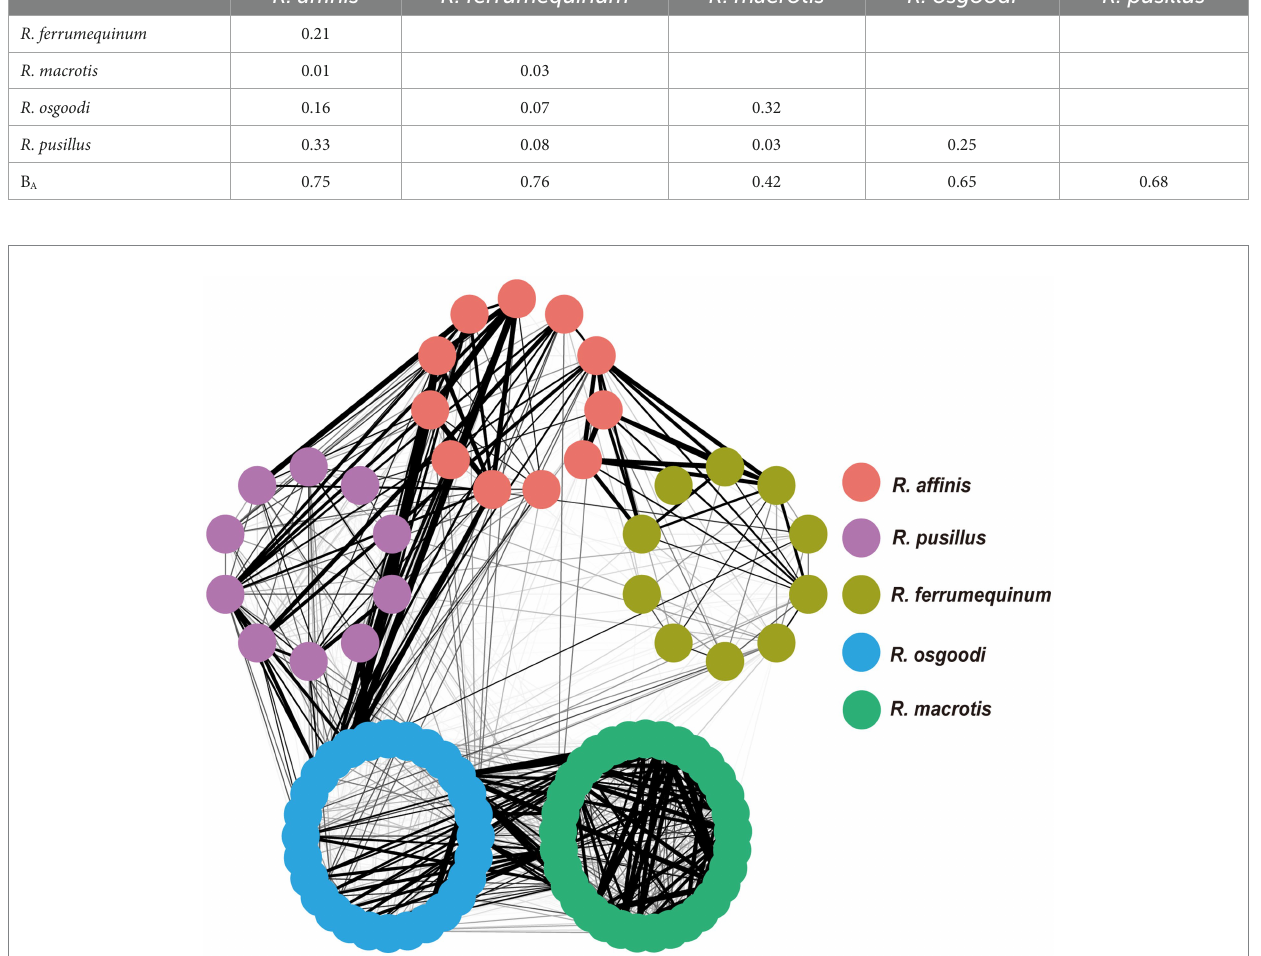
FIGURE 1 Network of five rhinolophid bat species. Each filled circle represents an individual, and the thicker the connection between circles, the higher dietary overlap between the